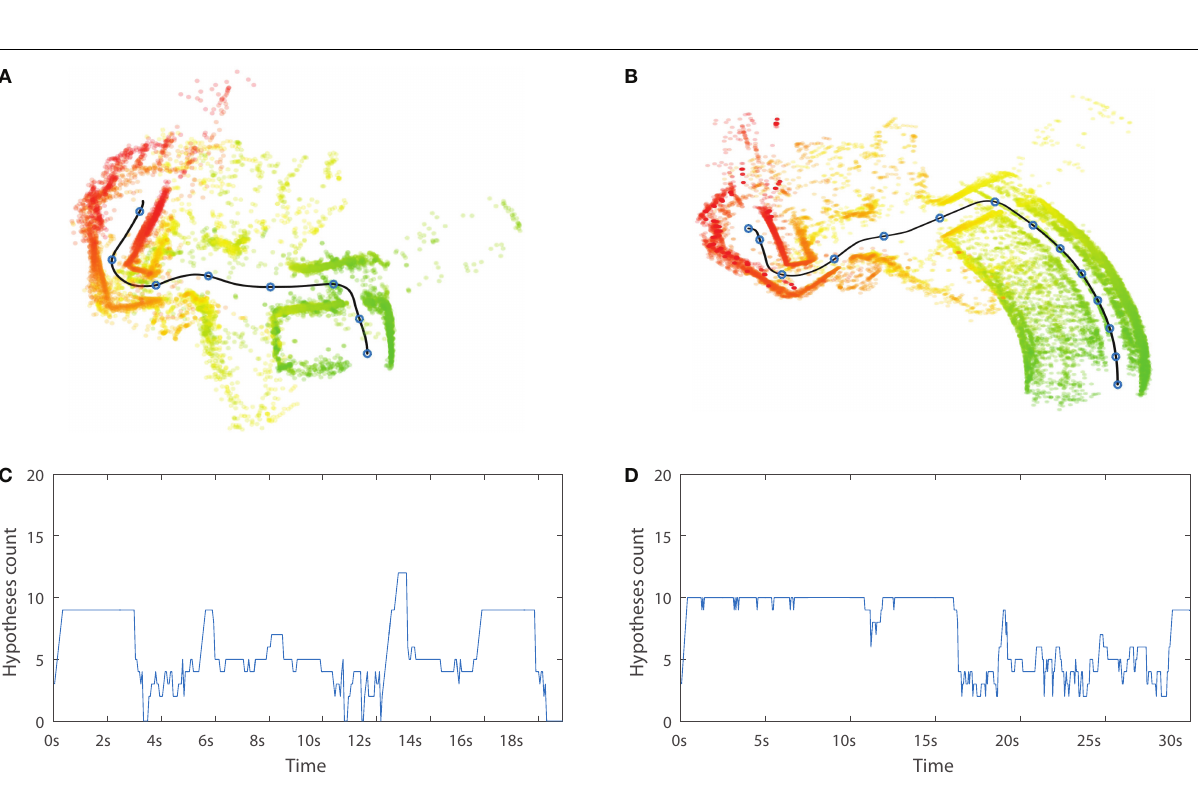
Fr ontiers in Robotics and AI |